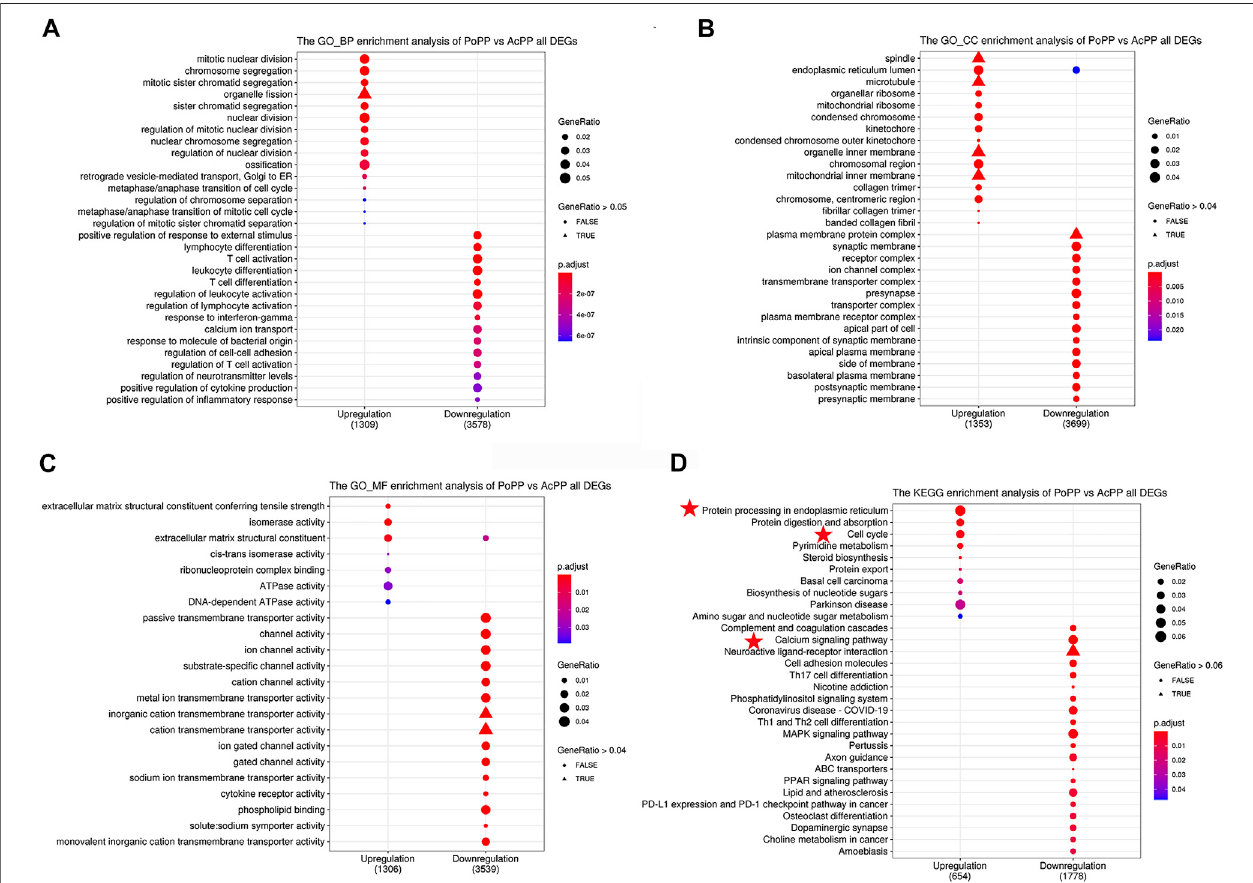
FIGURE 4 | GO and KEGG pathway analyses of all DEGs in the AcPP and the PoPP. (A – C) GO enrichment analysis: (A) biological process (BP), (B) cellular composition(CC),and (C) molecularfunction(MF). (D) KEGGenrichmentanalysis:itistobenotedthatthepathwaysmarkedbyredstarsmayplayimportantrolesinthe activation from the PoPP to the AcPP. AcPP: activated pedicle periosteum; PoPP: potentiated pedicle periosteum.